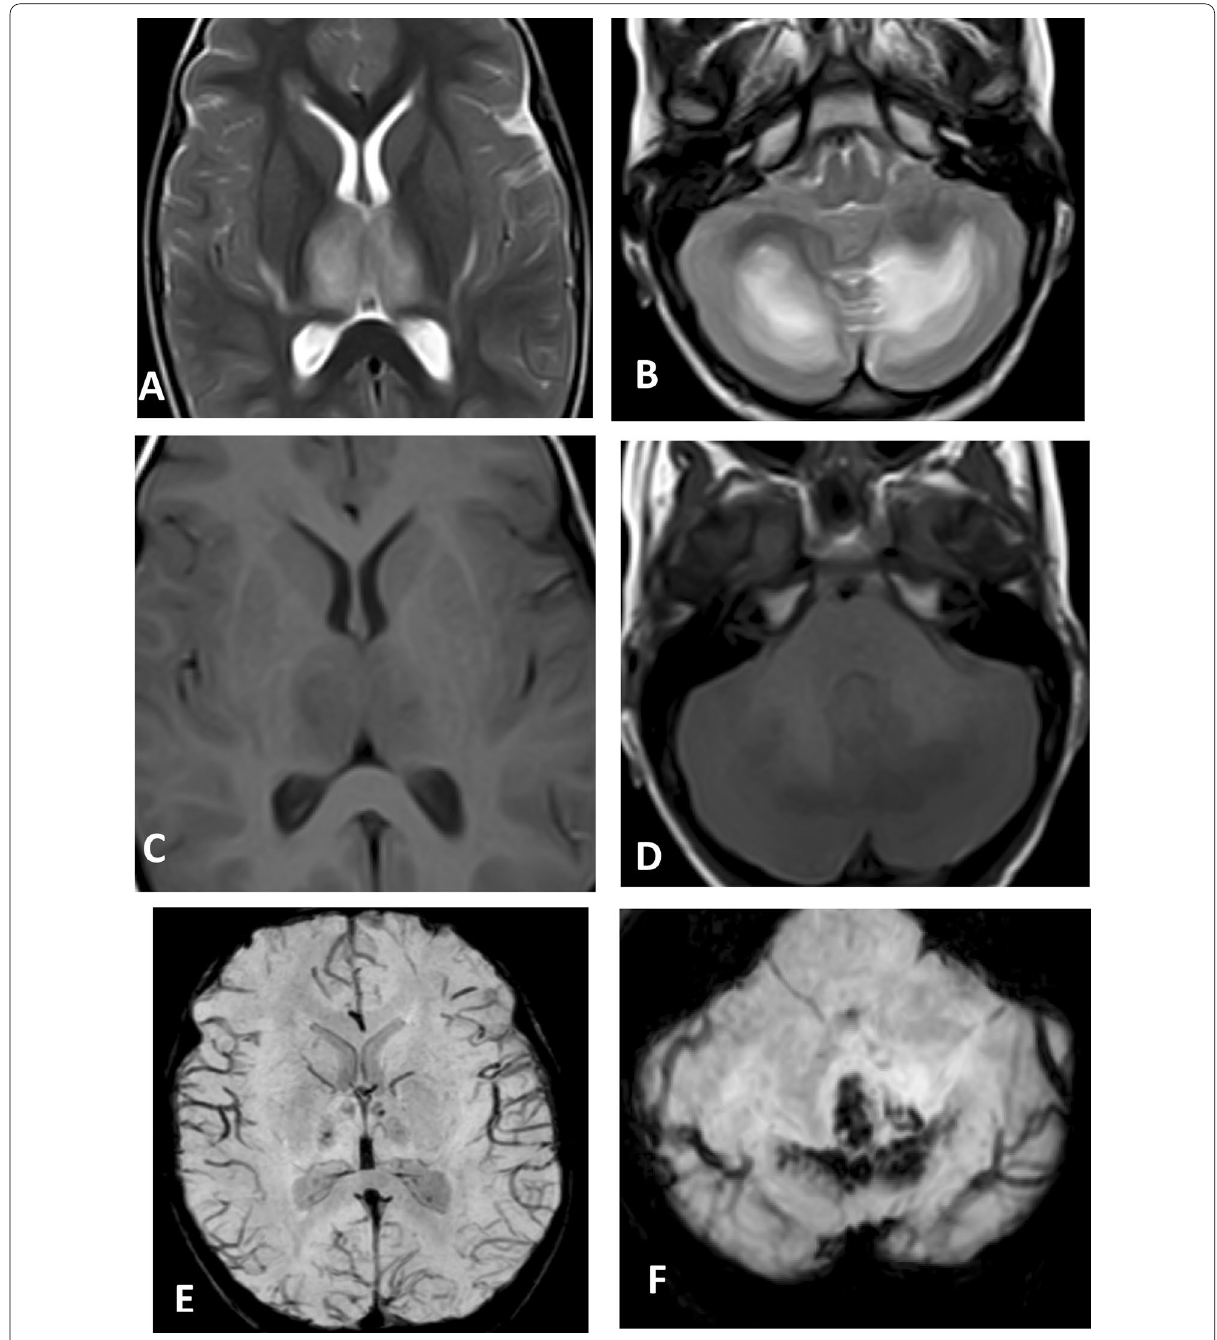
Fig. 2 A male child presented with acute necrotizing encephalopathy of childhood. A , B Axial T2 images showing the classical trilaminar bilateral symmetrical appearance in both thalami and both cerebellar hemispheres. C , D Axial T1 images show lesions of low signal. E , F SWI sequences show hemorrhagic component with subtle hemorrhage in thalami and huge hemorrhagic component in the posterior